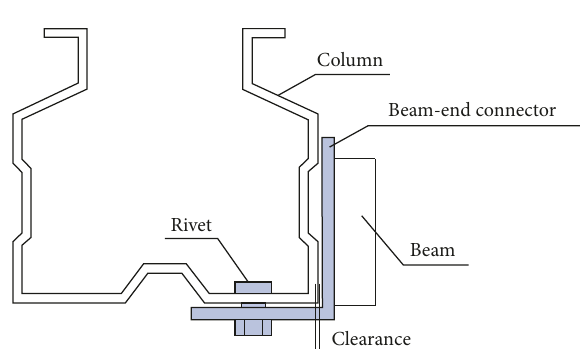
Figure 1: The rivet connection.